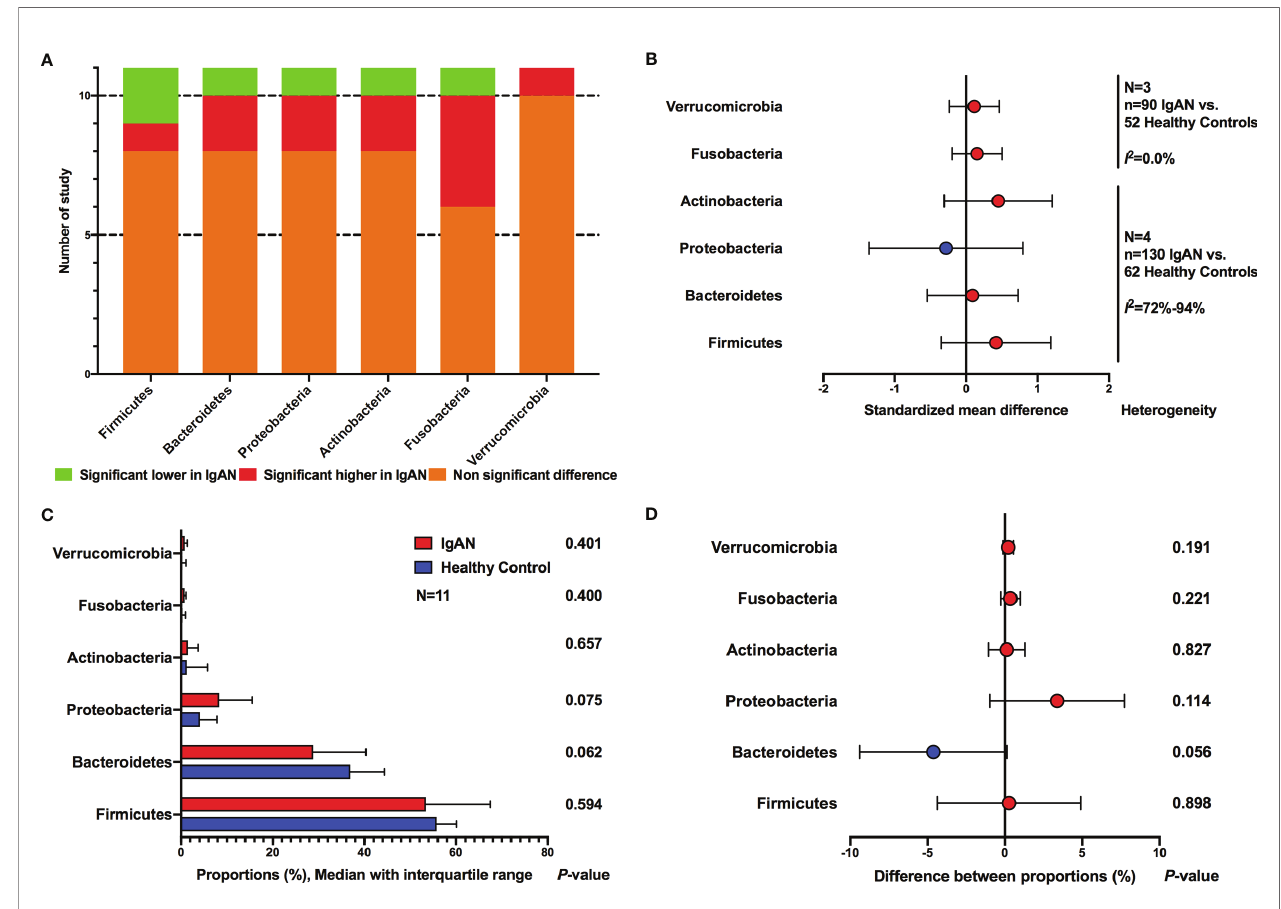
FIGURE 3 | Comparison of gut microbial composition between IgAN and healthy control at the phylum level. (A) qualitative analysis; (B) meta-analysis; (C) Wilcoxon rank-sum test of average abundances at study level; (D) T-test of average abundances at study